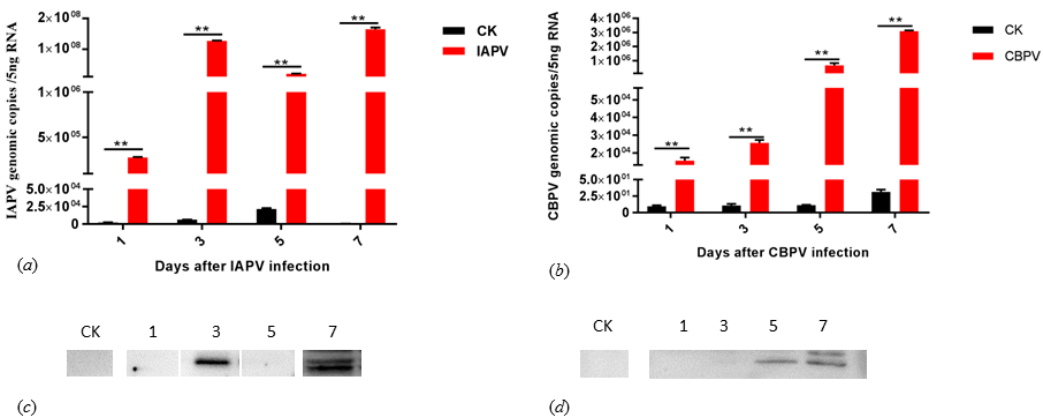
Figure 4. Quantification and identification of the level in bees and pathogenesis on bees injected with infectious clones of IAPV and CBPV. Expression levels of bees infected with infectious IAPV ( a ) and CBPV ( b ) at days 1, 3, 5, and 7. Detection of the IAPV virion protein 2, VP2 ( c ) and CBPV structural protein (SP) ( d ) of IAPV- and CBPV- infected bees at days 1, 3, 5, and 7. Note: Numbers 1, 3, 5, and 7 indicate infectious IAPV and CBPV bee samples collected on days 1, 3, 5, and 7. CK: blank control. Asterisks indicate significant differences (** p < 0.01).